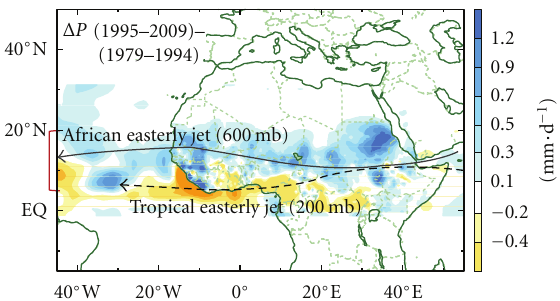
Figure 1: July-August precipitation di ff erences between the periods 1995–2009 and 1979–1994, from the University of Delaware data over land and the GPCP data over ocean. Jet cores along the African Easterly Jet and the Tropical Easterly Jet are indicated. The tropical monsoon westerly lies underneath the TEJ. The left bracket in red outlines the latitude zone used in Figures